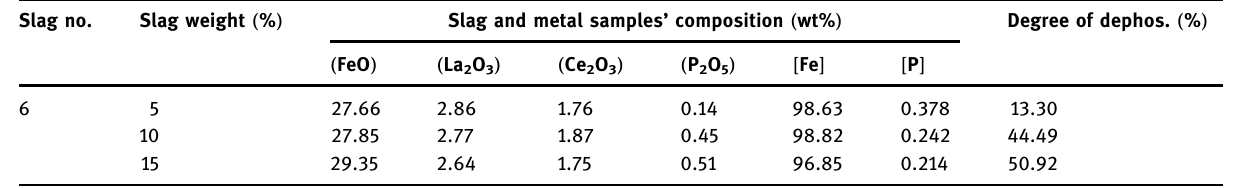
Table 5: Chemical composition of slags and metal after dephosphorization experiments at 1,550°C ( wt% ) Slag no. Slag weight ( % )